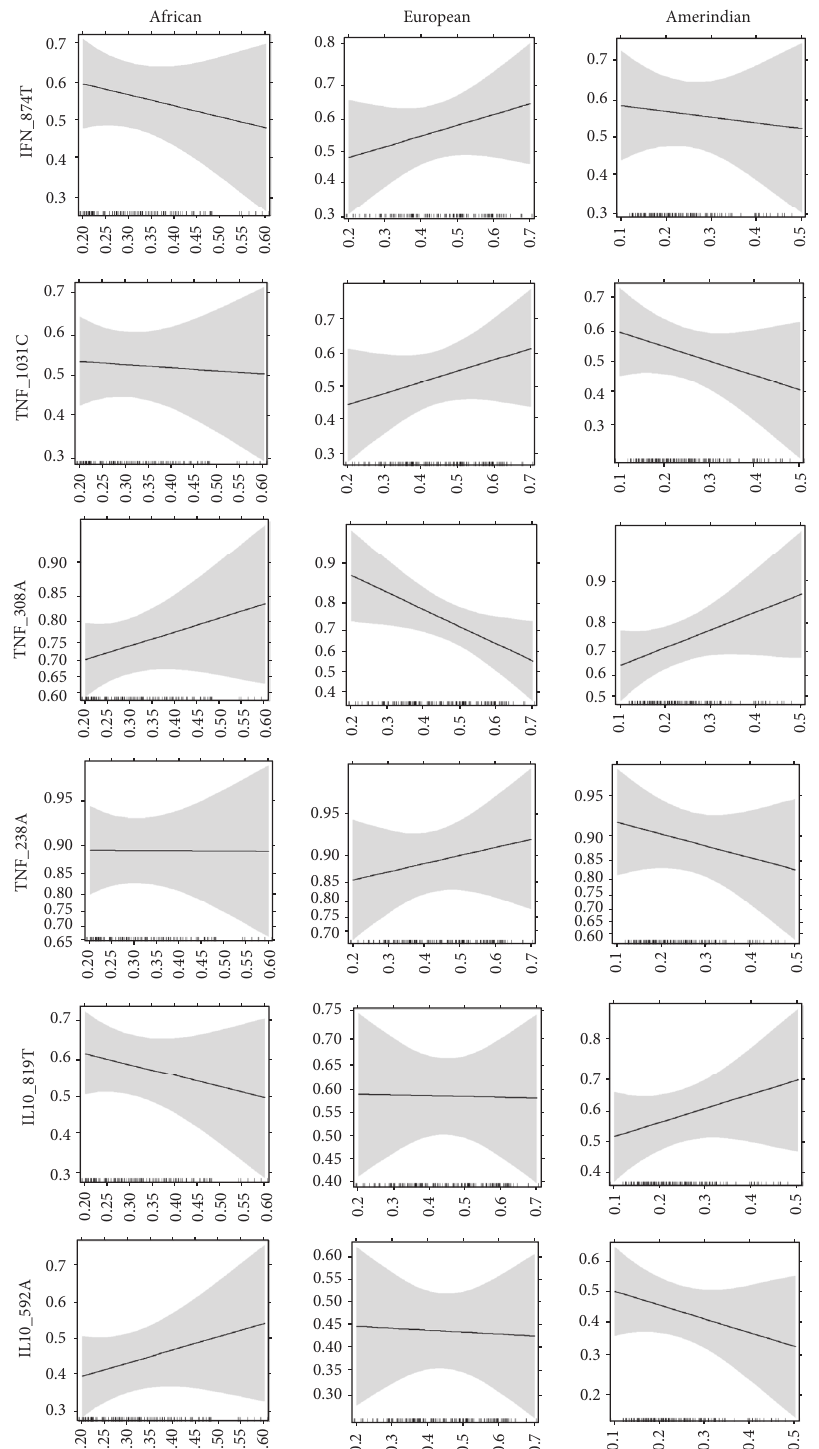
Figure 1: Binary logistic regression model used to evaluate the frequency of individuals carrying the mutant allele of all analyzed SNPs relative to the individual proportions of genetic ancestry. The shading around the lines represents the 95% confidence interval.The graph was constructed using the ggplot2 package in the R